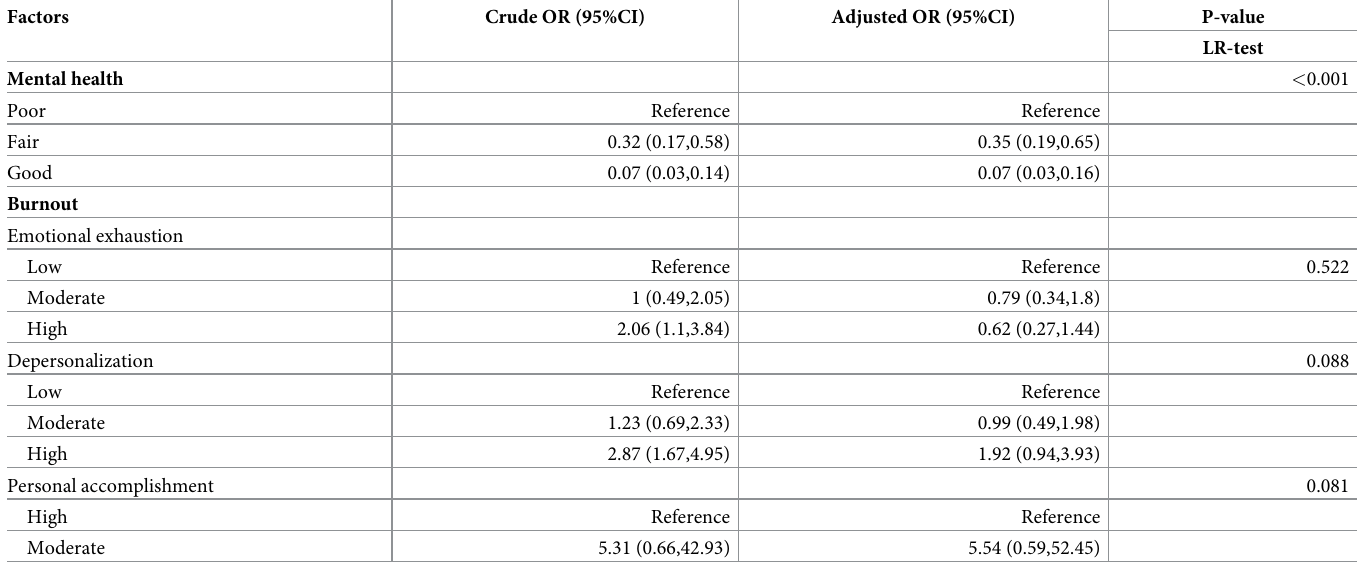
Table 4. The association between mental health, burnout and empathy level (N =